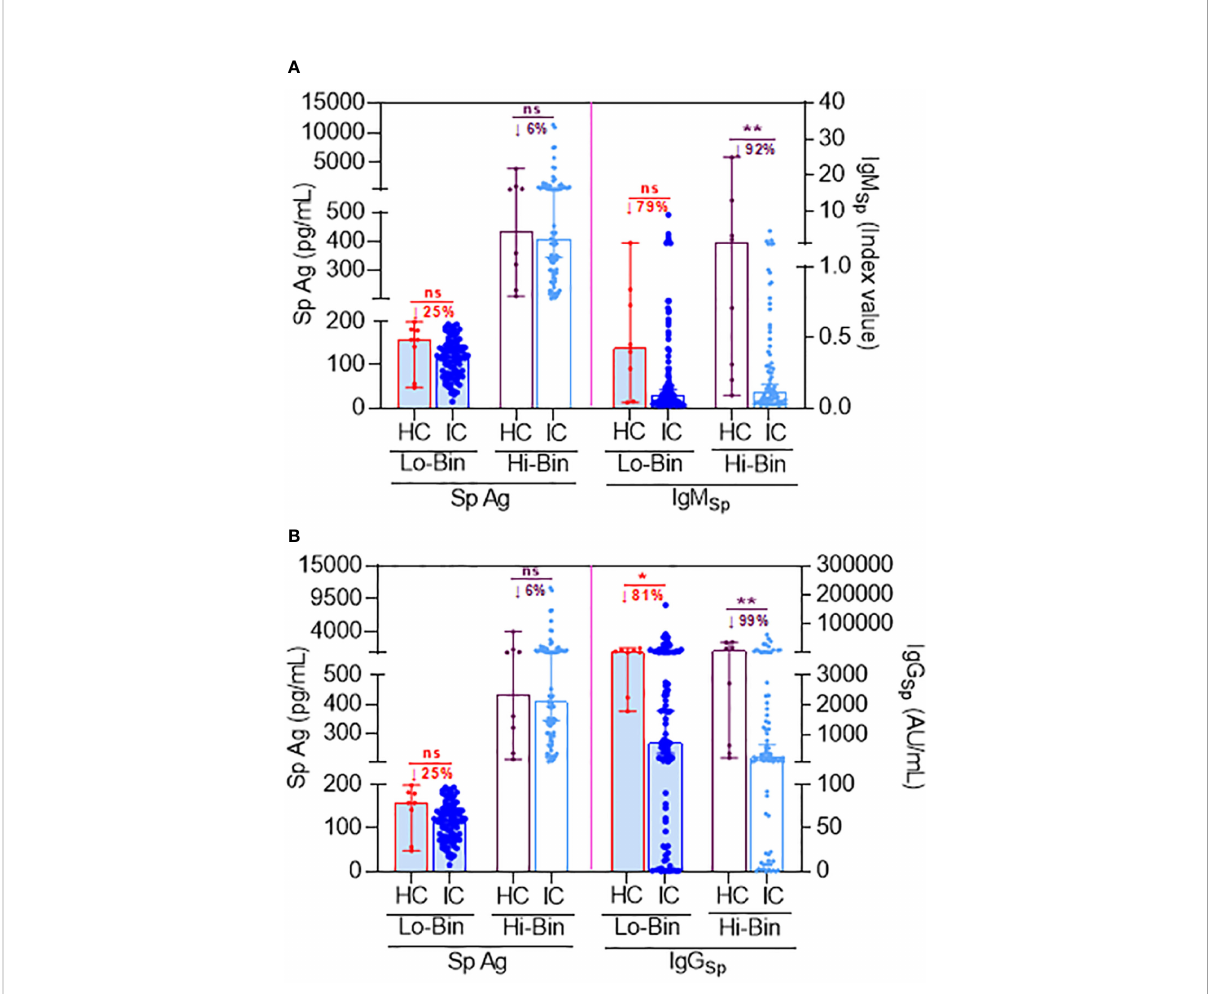
FIGURE 2 Comparison of Sp antigen to Sp antibody levels following 2D Co-mV administration under binned Ag thresholds between HC and IC patients that are on ISs. (A) Figure representing the effect of 2D Co-mV administration on Sp Ag levels (left pane) and IgM Sp antibody levels (right pane) created using bin algorithm by exploiting speci fi c threshold rules of Sp Ag (as described in results section) in corresponding HC subjects and IC patients receiving routine ISs combination that included mycophenolate and sirolimus. (B) Figure representing the effect of 2D Co-mV administration on Sp Ag levels (left pane) and IgG Sp antibody levels (right pane) created using bin algorithm by exploiting speci fi c threshold rules of Sp Ag (as described in results section) in corresponding HC subjects and IC patients receiving routine ISs combination that included mycophenolate and sirolimus. Box plot represents median with 95% CI. Comparison of the medians among the groups and the statistical difference was established using a two-tailed Mann Whitney t-test. The signi fi cant interaction denotes the following: (* p = 0.0144; ** p = 0.0013 (A) and 0.0089 (B) ; ns = p not signi fi cant vs the respective compared group, as indicated). 2D, two doses; Co-mV, COVID-19 mRNA vaccines; HC, healthy controls; IC, immunocompromised; ISs, immunosuppressants; Sp, spike; IgM, immunoglobulin M; IgG, immunoglobulin G; AU, arbitrary units; CI, con fi dence interval; Ag; antigen; Lo, low; Hi, high; ↓ ,